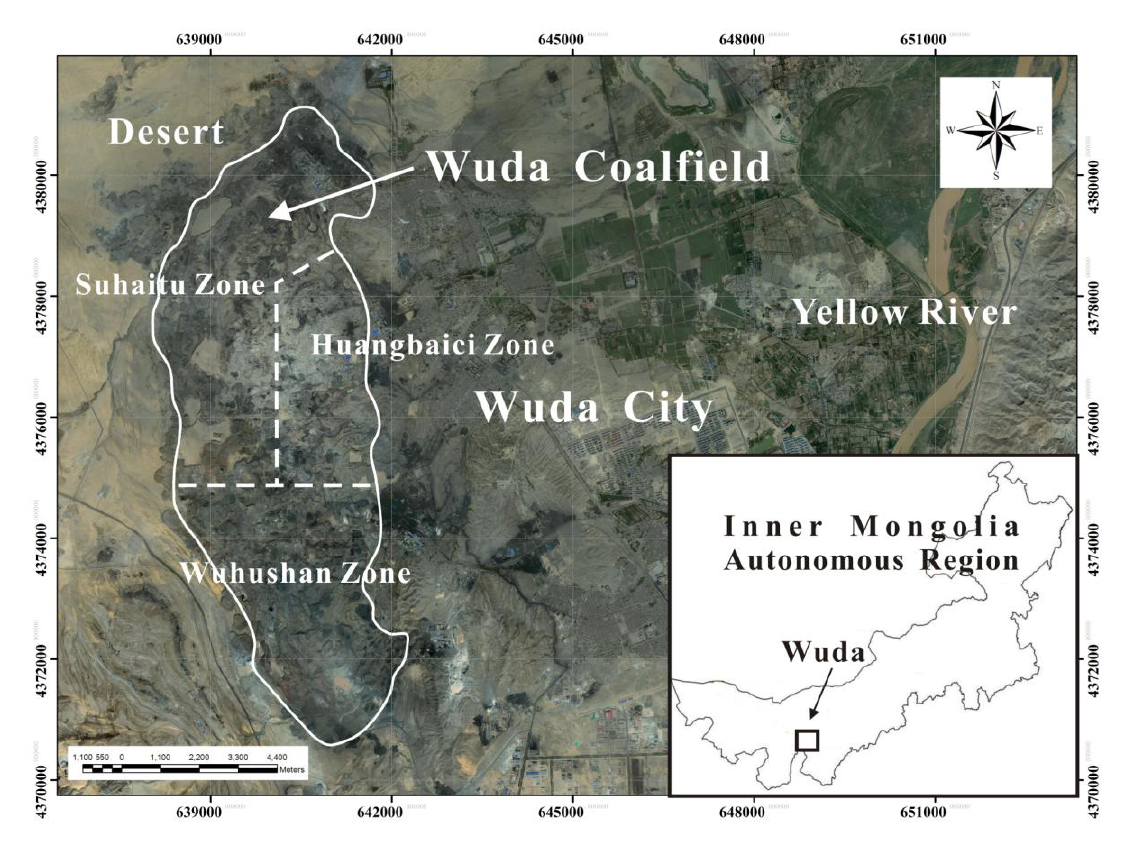
Figure 1. Geographic location of the Wuda